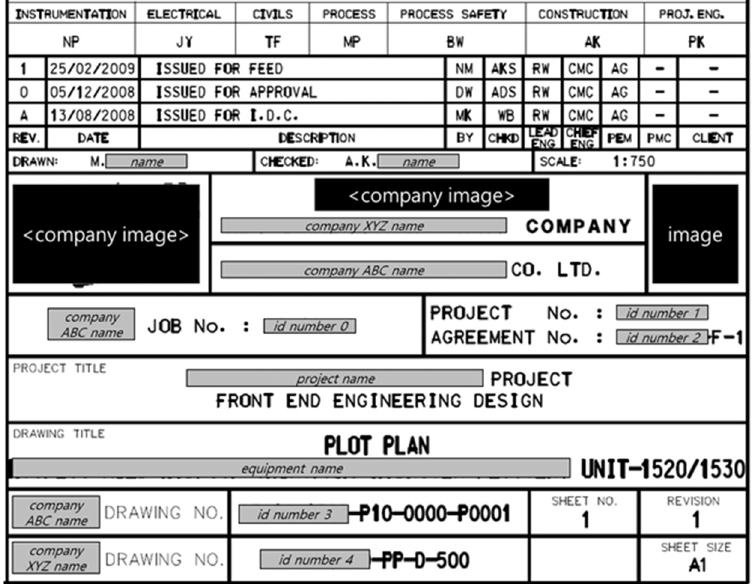
Figure 2. A table example in an engineering specification drawing.